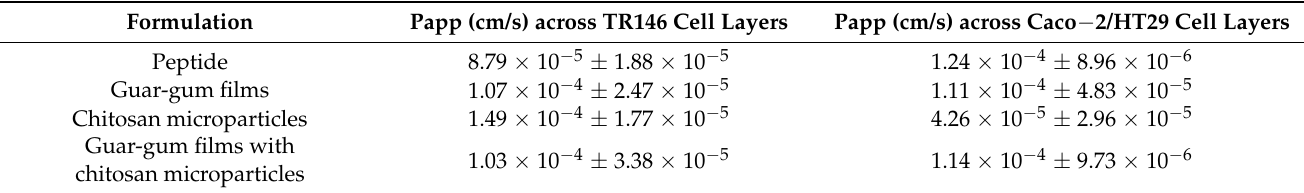
Table 2. Apparent permeability coefficient of relaxing peptide across TR146 and Caco-2/HT29 co-culture model. Formulation Papp (cm/s) across TR146 Cell